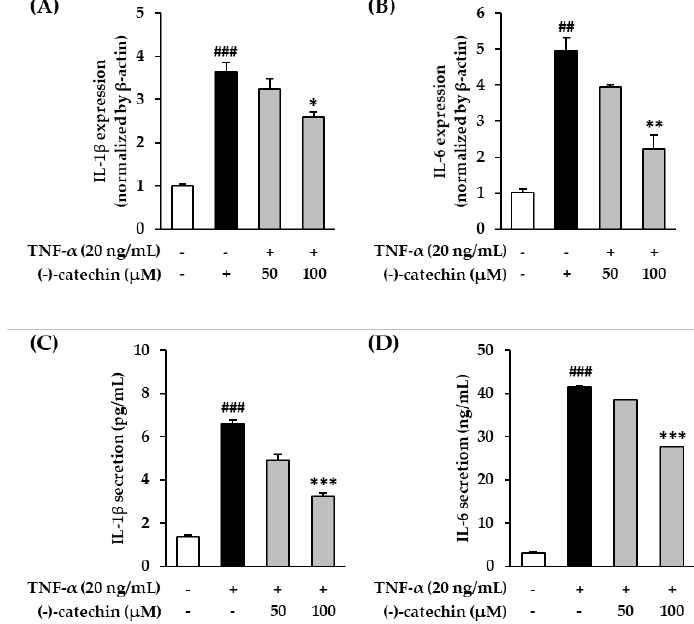
Figure 6. E ff ect of (-)-catechin on proinflammatory cytokines interleukin (IL)-1 β and IL-6 in tumor necrosis factor- α (TNF- α )-stimulated normal human dermal fibroblasts (NHDFs). ( A , B ) The cells were treated with 50 and 100 µ M (-)-catechin for 1 h, and then with 20 ng / mL TNF- α for 4 h. The mRNA level of IL-1 β and IL-6 was measured by qRT-PCR. ( C , D ) The NHDFs were treated with 50 and 100 µ M (-)-catechin for 1 h, and then with 20 ng / mL TNF- α for 12 h. The levels of IL-1 β and IL-6 were measured using the ELISA kit. The data are presented as mean ± SEM (N = 3). ## p < 0.01 and ### p < 0.001 compared with the untreated group; * p < 0.05, ** p < 0.01, and *** p < 0.001 compared with the TNF- α -treated group.